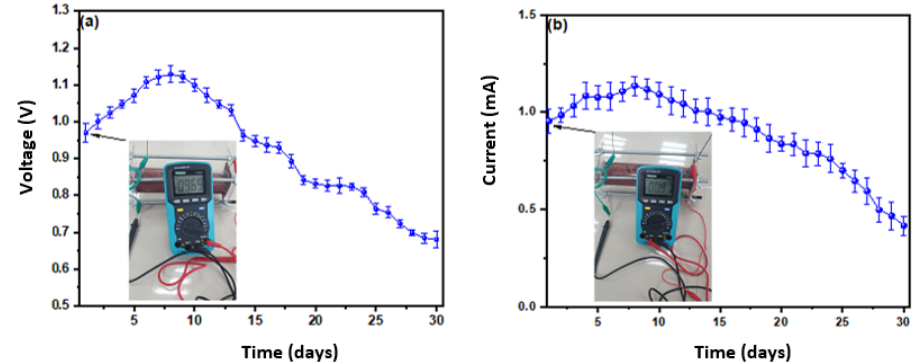
Figure 2. Monitoring the generation of ( a ) voltage and ( b ) current of MFC.